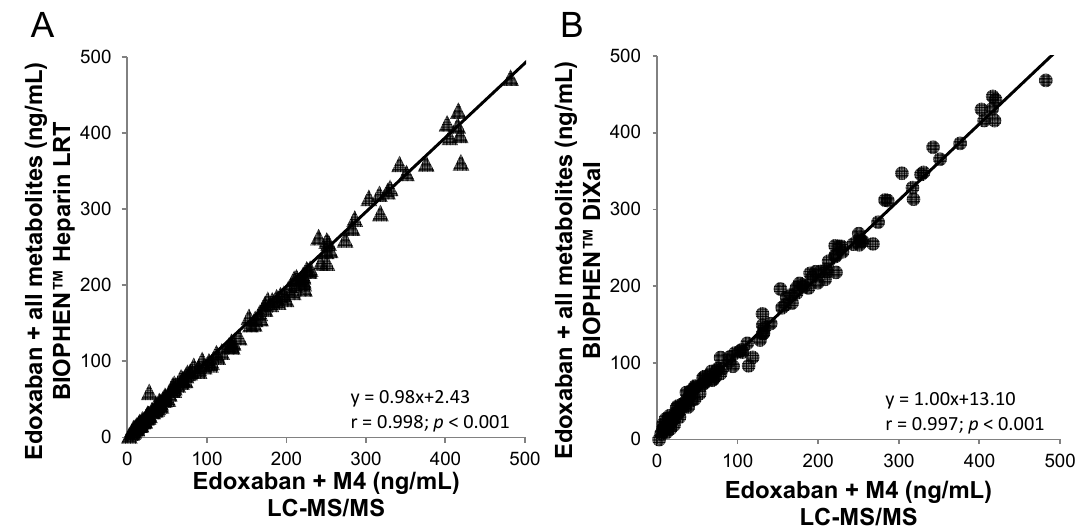
Figure 4. Correlation between anti-FXa bioassays and the LC-MS/MS (edoxaban + M4) method on 144 edoxaban plasma samples from healthy volunteers. ( A ) BIOPHEN™ Heparin LRT and ( B ) BIOPHEN™ direct factor Xa inhibitor (DiXaI) (data not published).